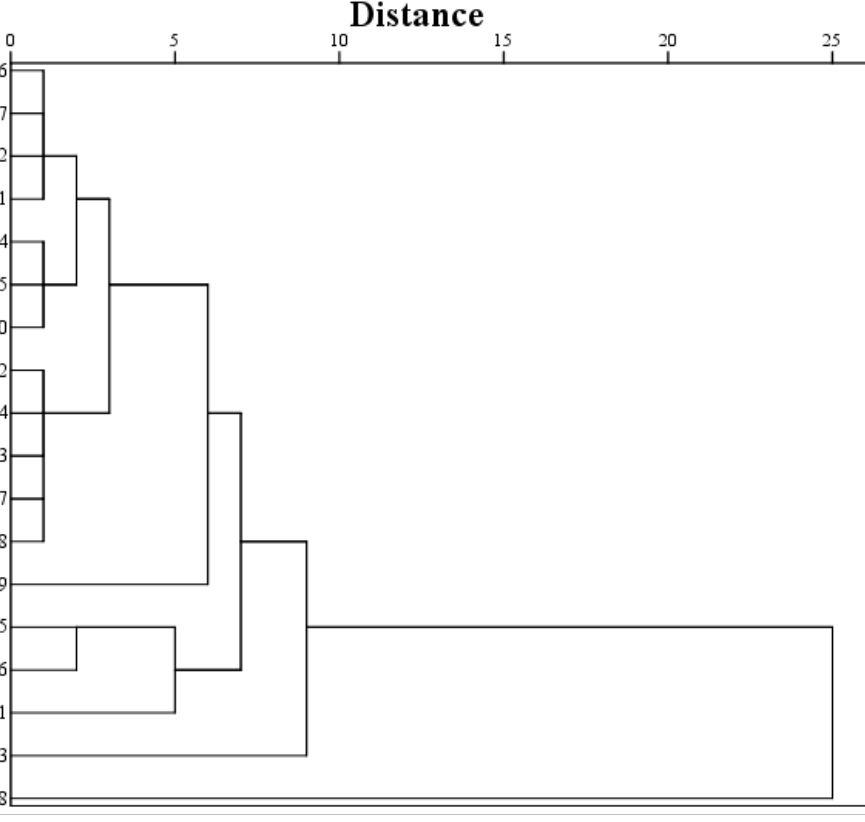
Figure 5. Hierarchical tree dendrogram of the 18 populations of Camellia oleifera based on fatty acid composition and fruit phenotypic characteristics.